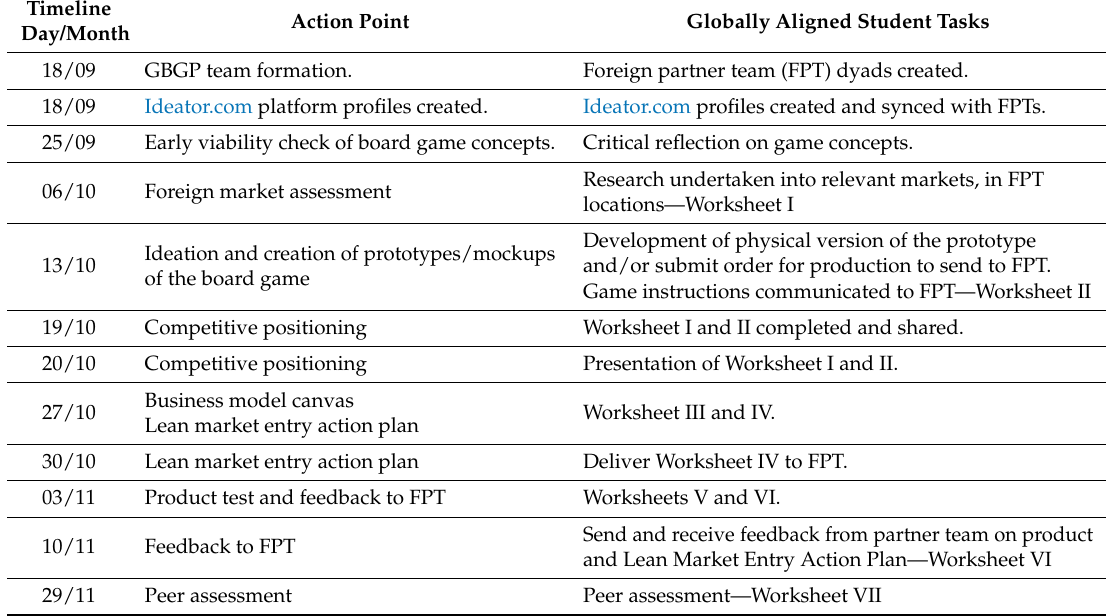
Table 2. Global Board Game Project (GBGP)